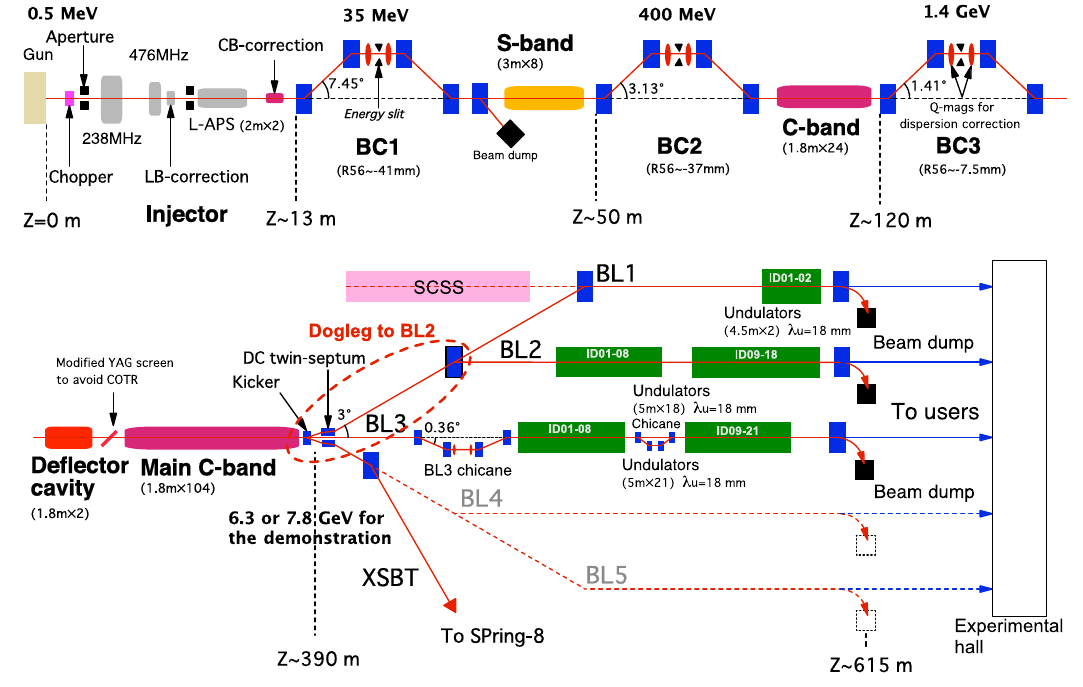
FIG. 1. Schematic of the SACLA facility.